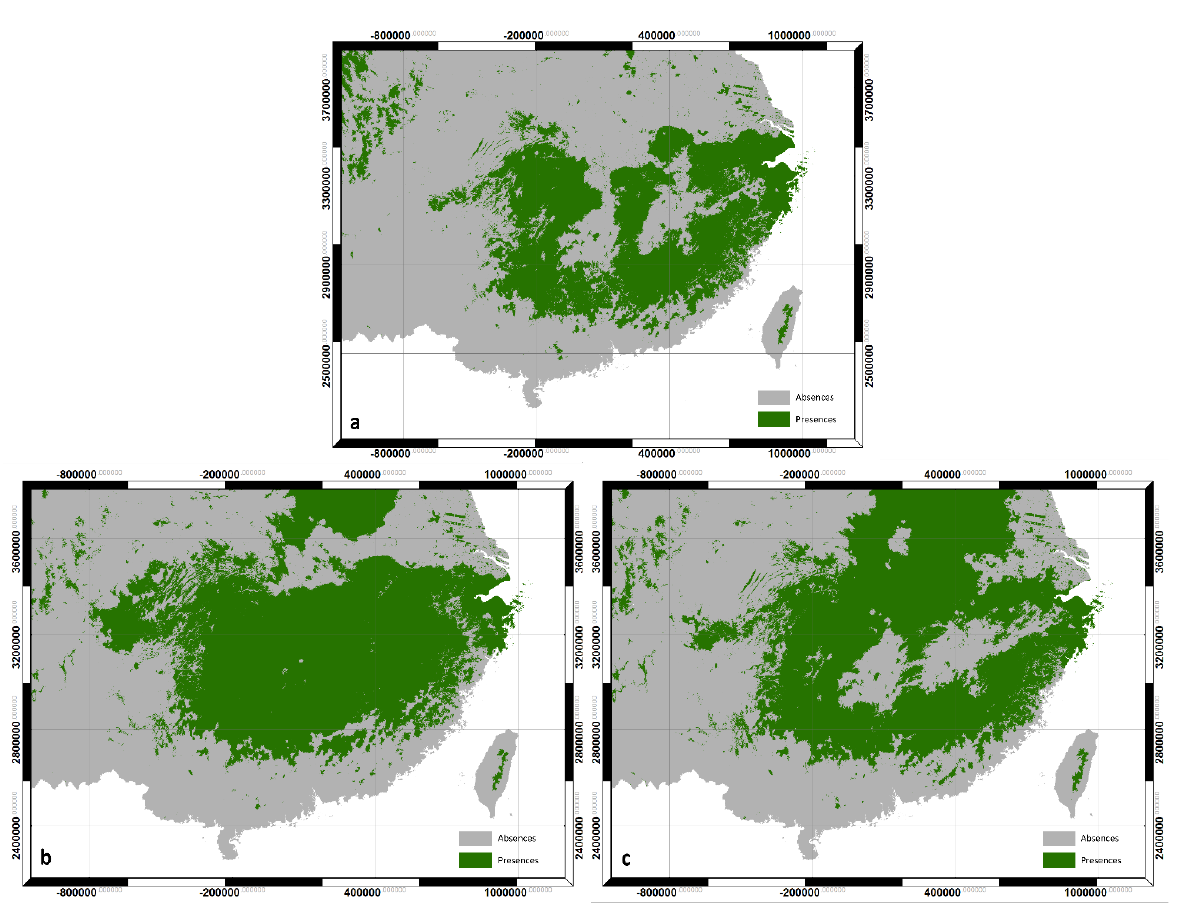
Figure 5. Chinese fir distribution under different climate projections; ( a ) current; ( b ) A1B projection; ( c ) A2